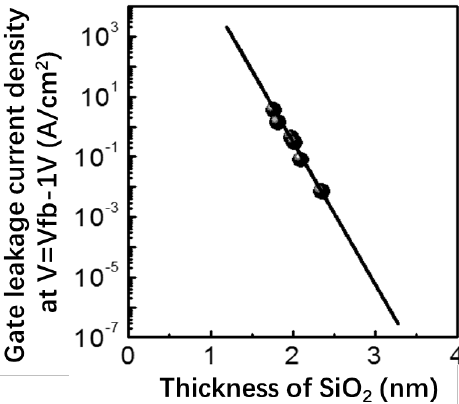
Figure 4. Gate leakage current density as a function of SiO 2 physical thickness.